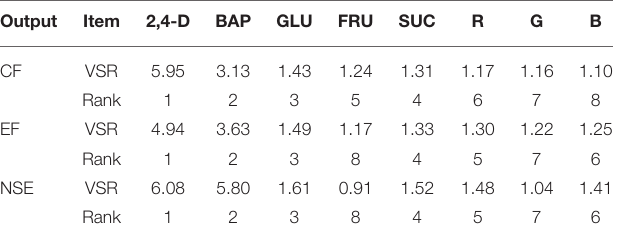
TABLE 2 | Importance of growth factors for callogenesis frequency (CF), embryogenesis frequency (EF), and number of somatic embryo (NSE) of chrysanthemum according to sensitivity analysis on the developed ANFIS model to rank the importance of growth factors.